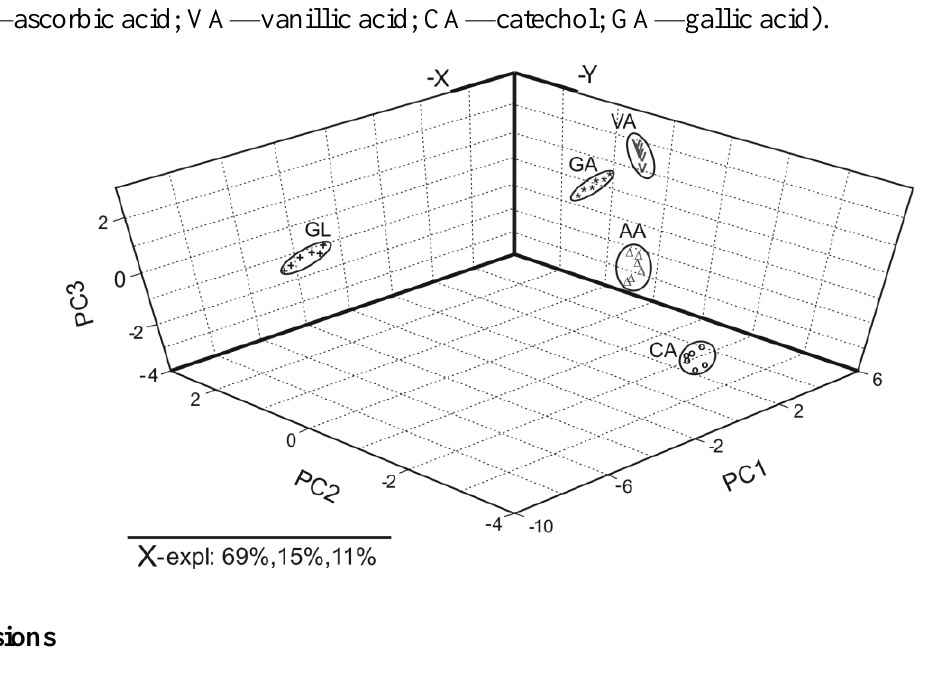
Figure 7. 3D score plot of PCAs of CPEs exposed to antioxidants. (GL—glutathione; AA—ascorbic acid; VA—vanillic acid; CA—catechol; GA—gallic